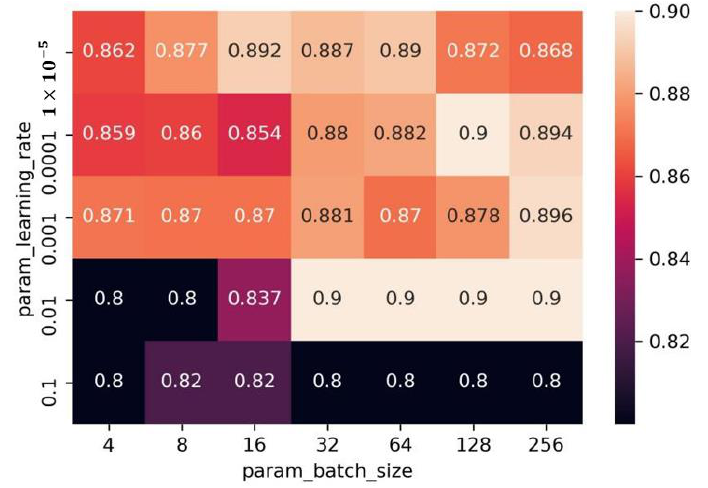
Figure 10. Network score heat diagram of each group with hyper-parameters.